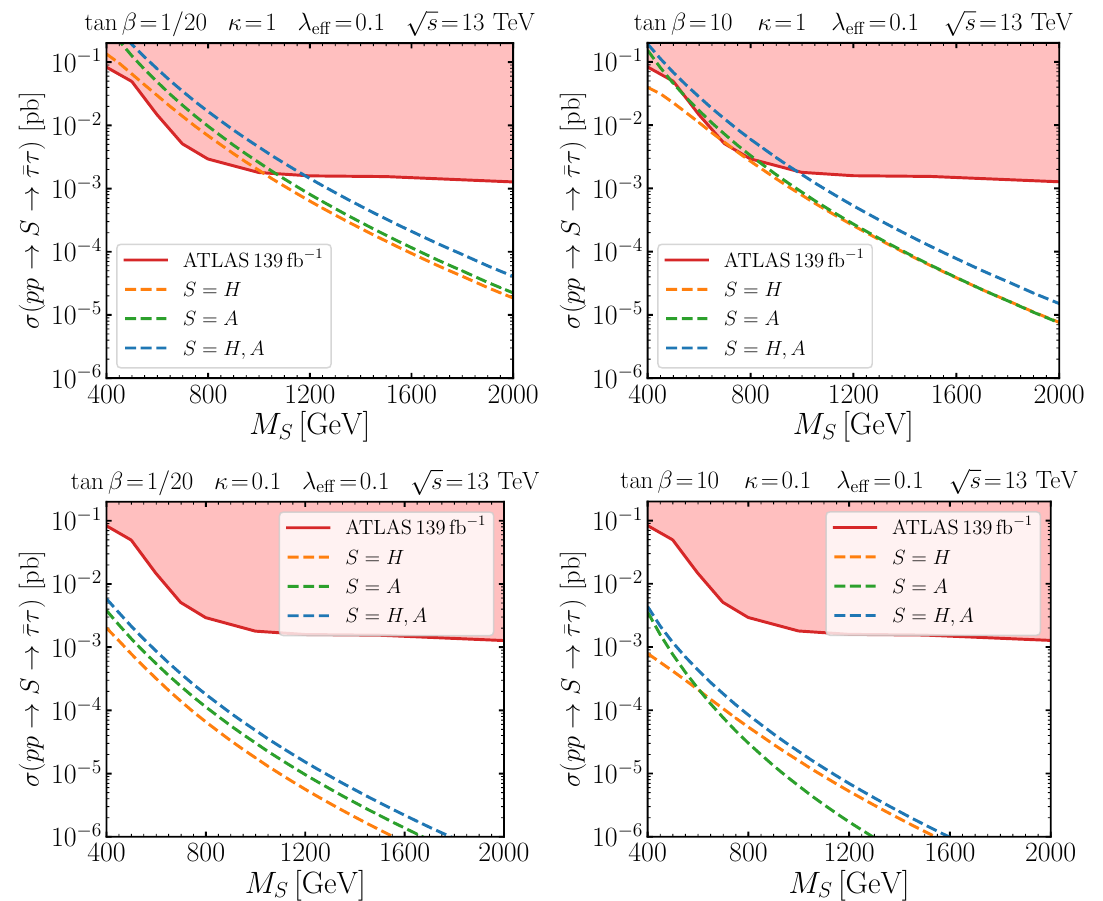
Figure 4 . Production cross-section for the process pp → S → ¯ ττ . The region shaded in red corresponds to the experimental limit by ATLAS [28]. The dashed orange (green) line corresponds to the production of H ( A ), while the dashed blue line takes into account both. In the top-left panel we fix tan β =1 / 20 and κ = 1 , in the top-right panel tan β =1 and κ = 1 , in the bottom-left panel we fix tan β =1 / 20 and κ = 0 . 1 , and in the bottom-right panel tan β =1 and κ = 0 . 1 . In the four cases we fix λ = 0 . 1 eff